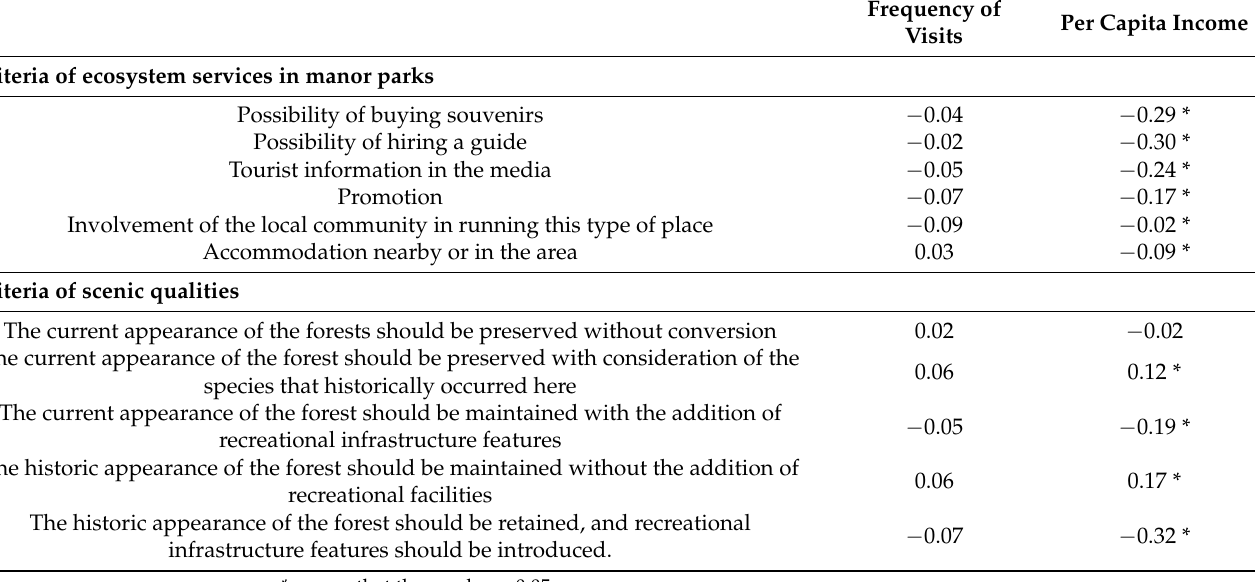
Table 2. Correlation analysis between the selected criteria of ecosystem services and the criteria of scenic qualities and between the frequency of visits and per capita income. Frequency